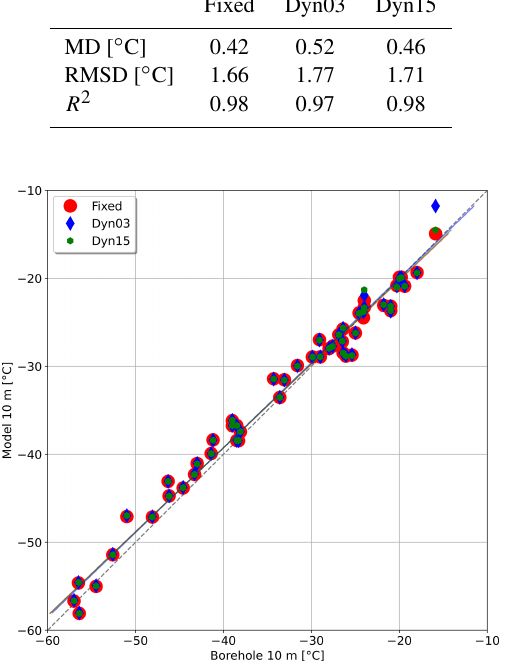
Figure 7. The dots are 10m temperature from boreholes vs. mean model 10m temperature. The solid lines are the regression lines of first order, and the grey dashed line shows the